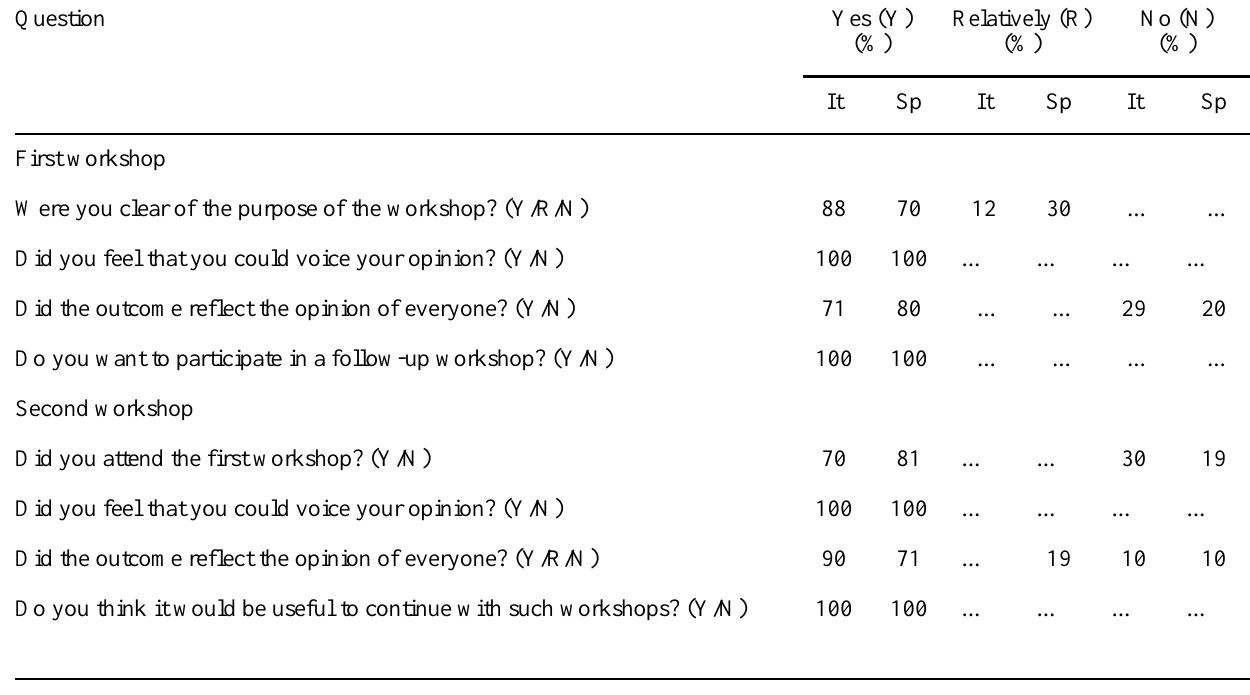
Table 2 . Selected results from the stakeholder questionnaires in Spain (Sp) and Italy (It), conducted after the first and second series of scenario workshops in